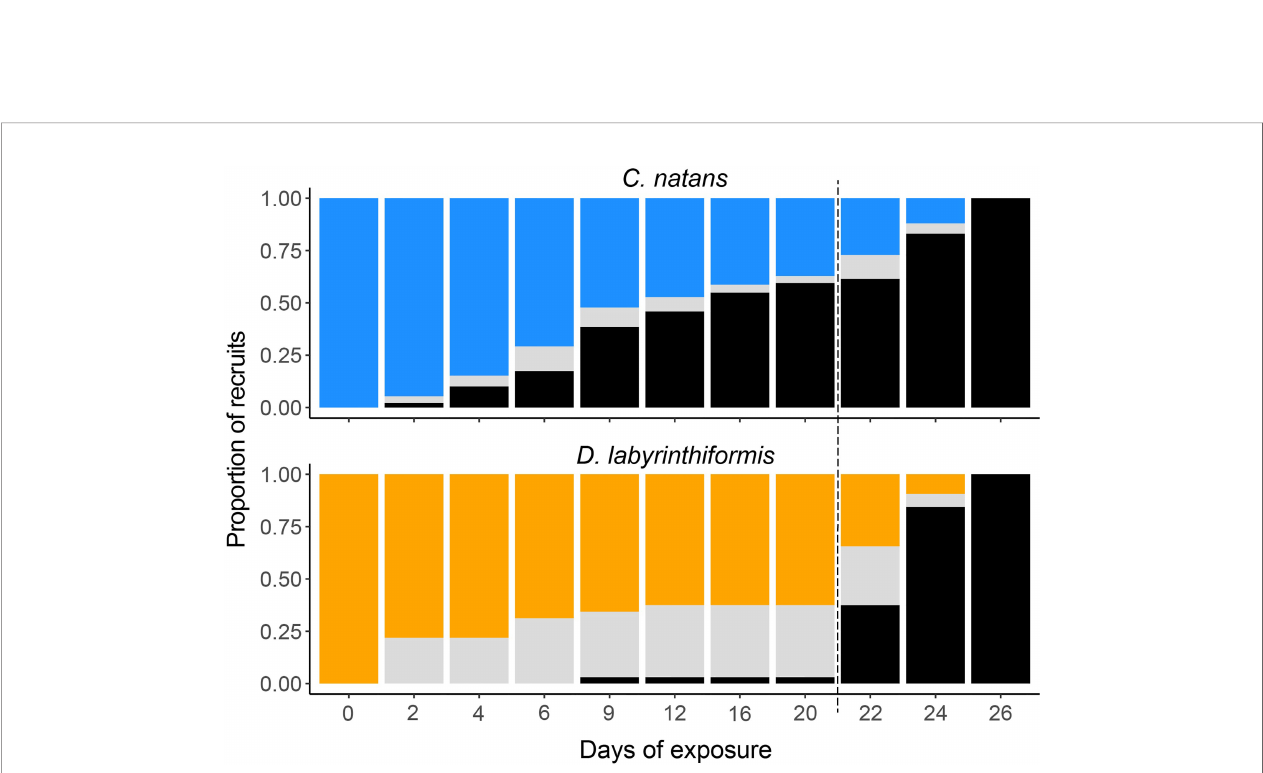
FIGURE 4 | Condition of C. natans and D. labyrinthiformis recruits throughout SCTLD exposure. Blue ( C. natans ) and orange ( D. labyrinthiformis ) represent apparently healthy recruits, gray represents recruits exhibiting active disease lesions, and black represents recruits that have died. Dashed line indicates start of Exposure